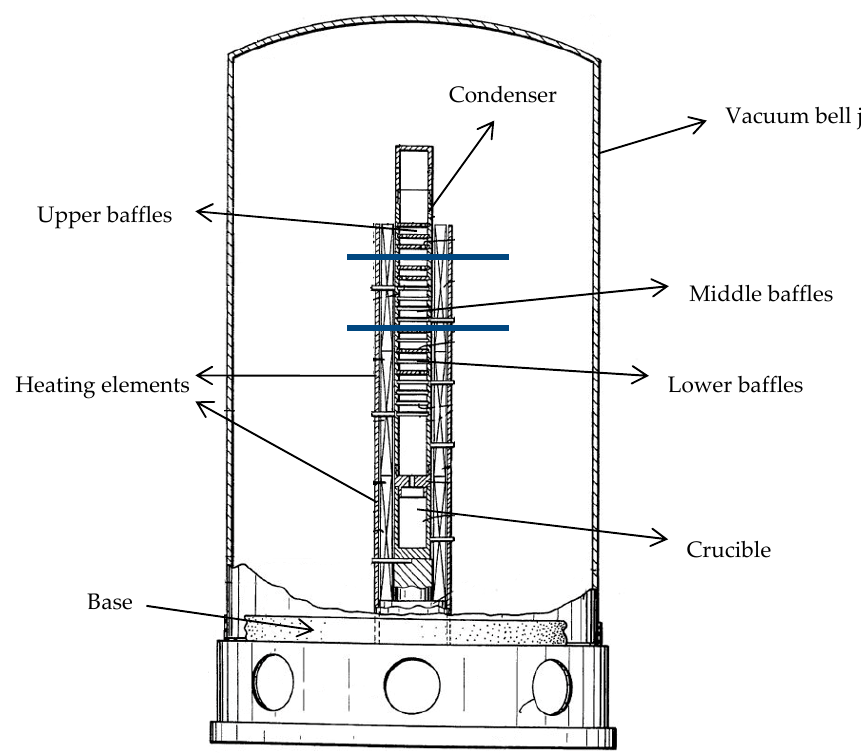
Figure 5. Vacuum distillation column as devised by Lam and Marx.